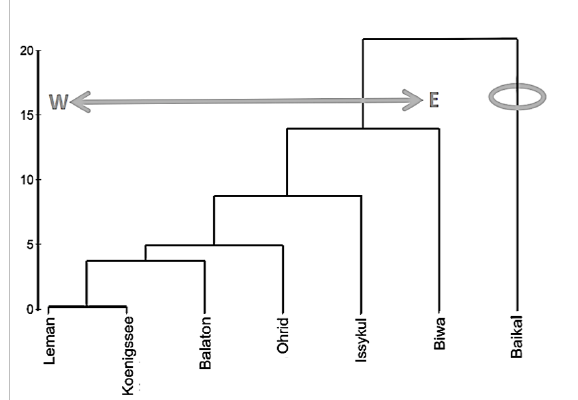
Figure 2. Cluster analyses of nematode communities in major lakes based on Jaccard similarity. A W-E gradient is revealed. The unique community composition of lake Baikal reveals its high share of endemic species. These lakes are located, respectively, in